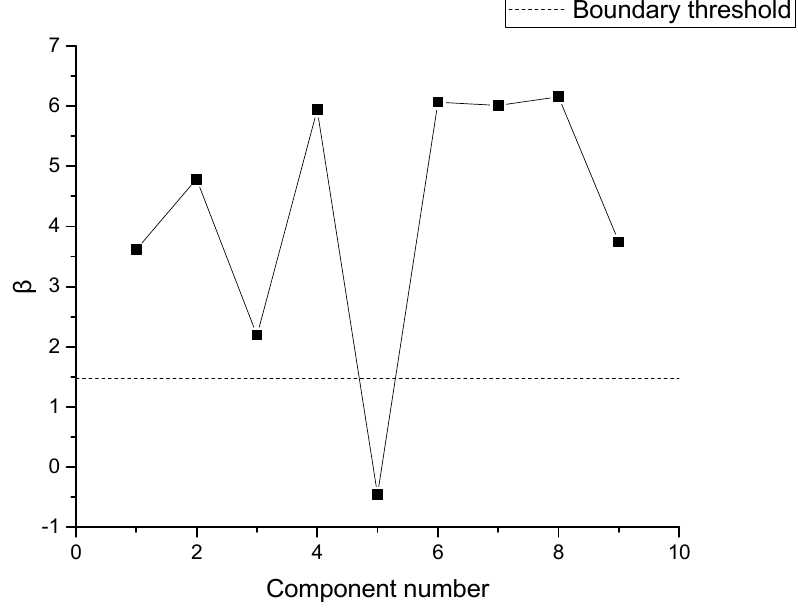
Figure 5. Reliability index in at the first stage of the failure process.